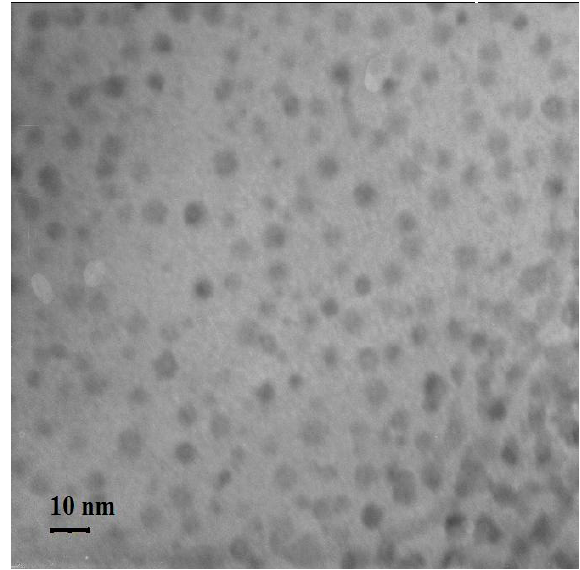
Figure 2. TEM images of the 1 mol% europium ion (Eu 3+ )-doped SnO 2 –SiO 2 glass-ceramic waveguide treated at 1000 °C for five hours showing tin dioxide (SnO 2 ) nanocrystals dispersed in the amorphous matrix.